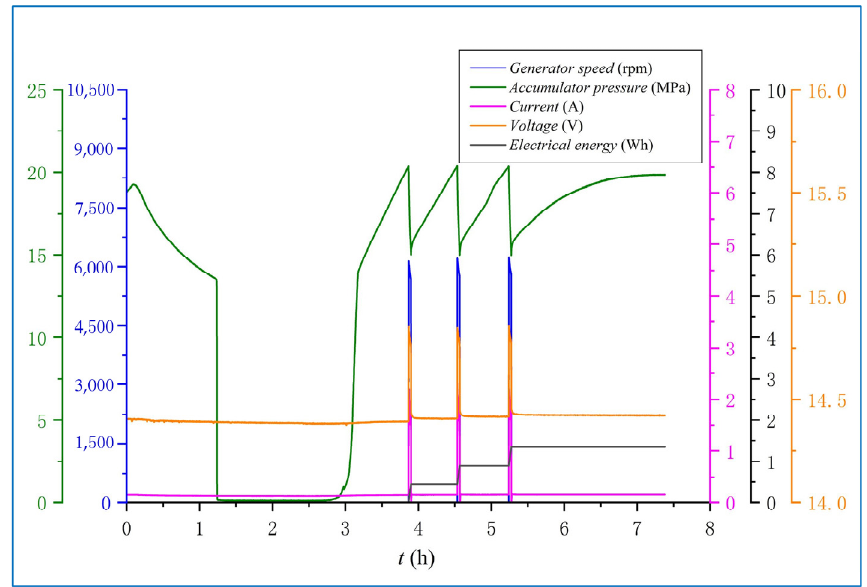
when the accumulator pressure fluctuates between 15 MPa and 20 MPa, and this process Figure 12. The depth and temperature curves in the sea trial. Figure 12. The depth and temperature curves in the sea trial. lasts for 180 s in total.